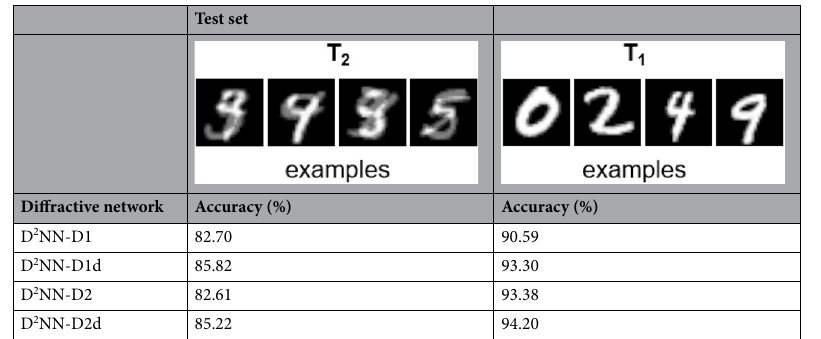
Table 1. The summary of the optical blind inference accuracies achieved by the presented diffractive optical networks on test sets T 2 and T 1 along with some input examples from these datasets.